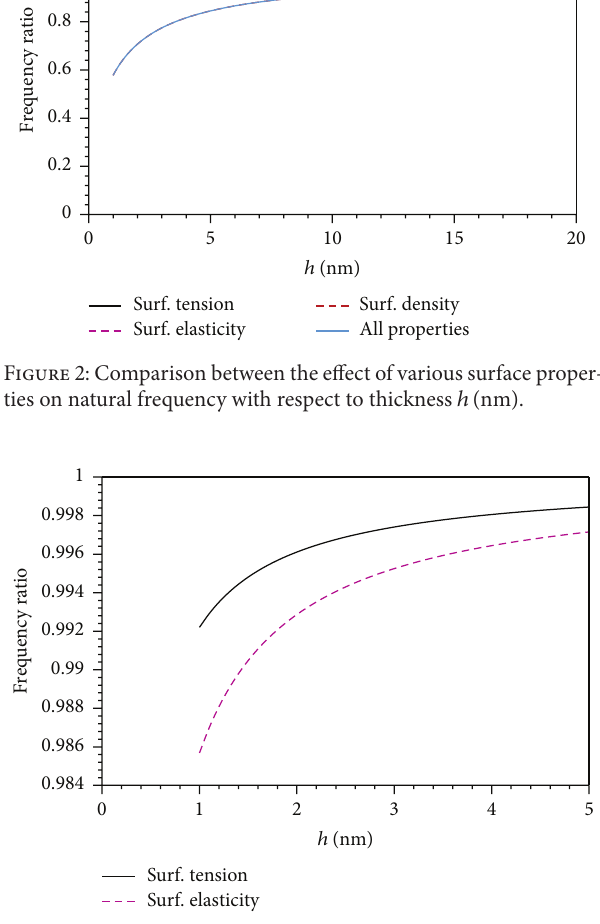
Figure 3: Comparison between the effect of surface tension and surface elasticity on natural frequency with respect to thickness ℎ